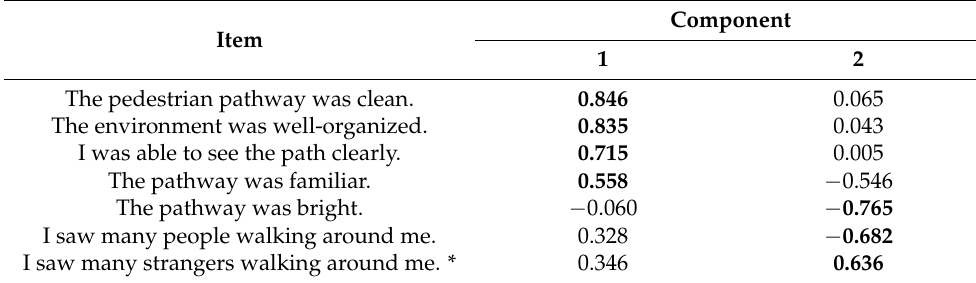
Table 4. Principal component analysis results for the ratings of the walking environment. Item The pedestrian pathway was clean. 0.846 0.065